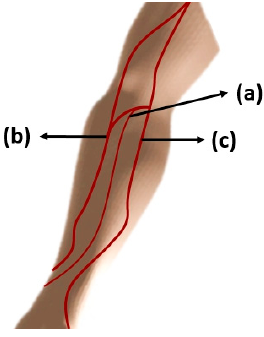
Figure 5. The antecubital fossa with the veins for venipuncture.